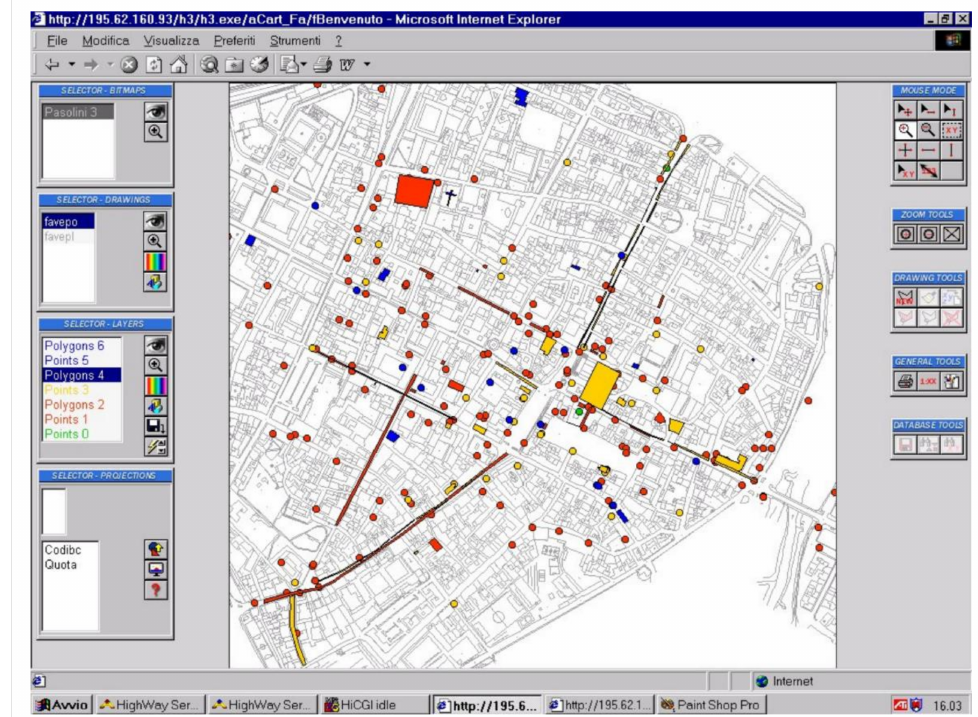
Figure 3. Italy C.A.R.T. project: graphic illustration of how to present information on the map through polygons of different colors using Odysseus software.